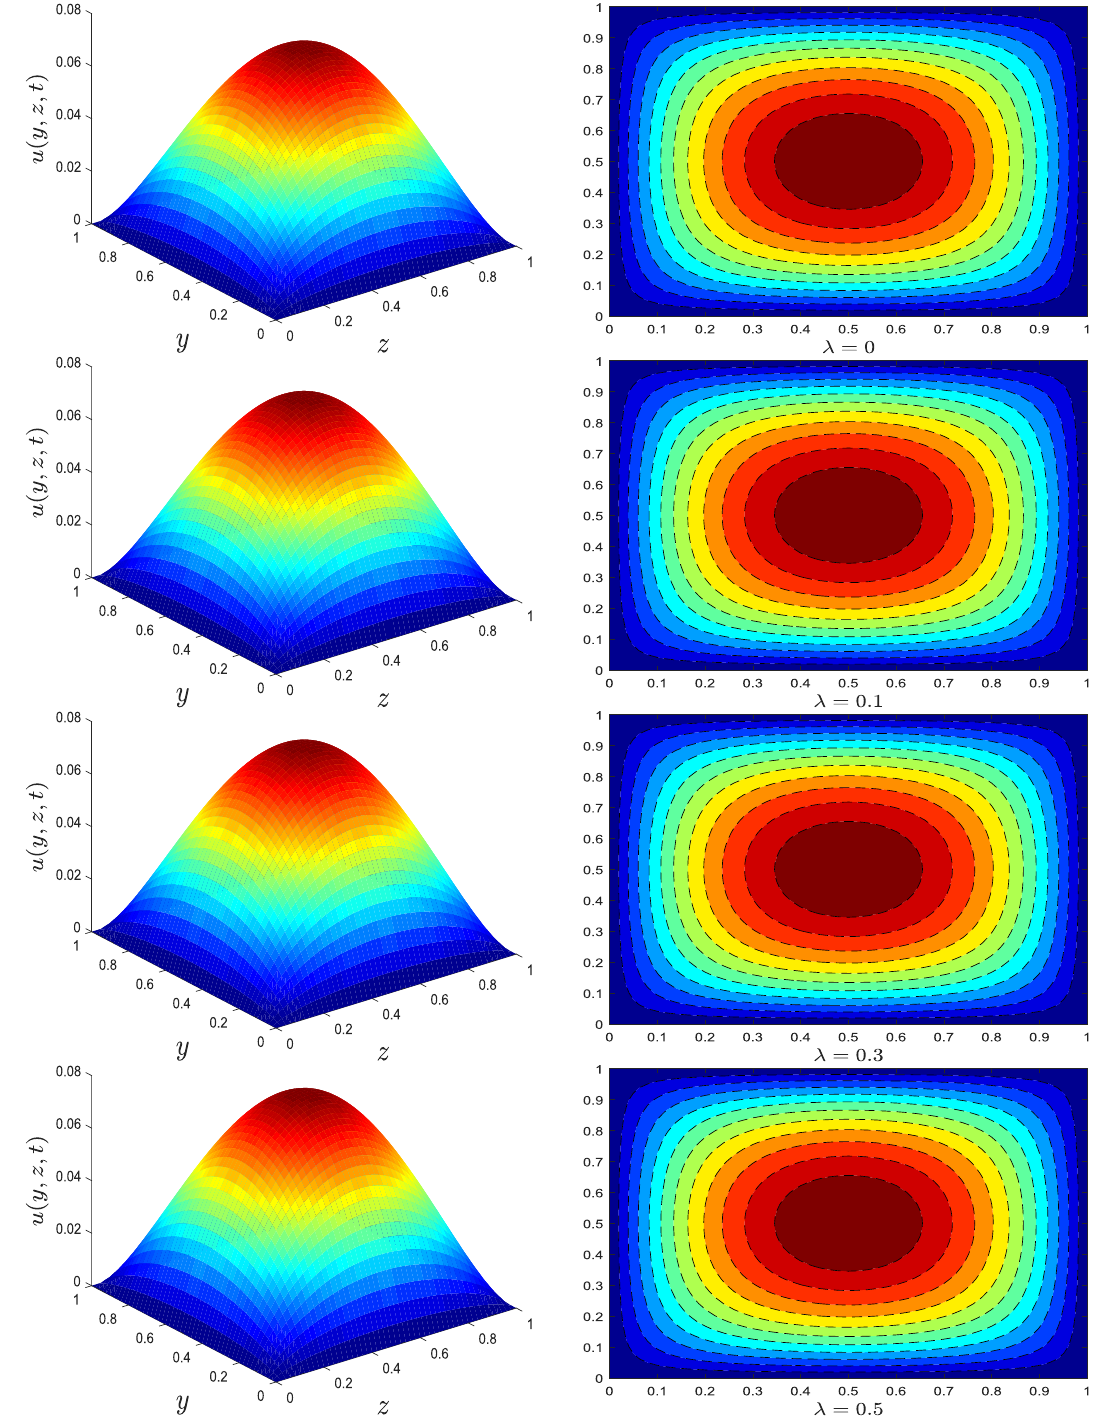
Figure 2. Velocity profile for different values of relaxation time parameter (cid:31)